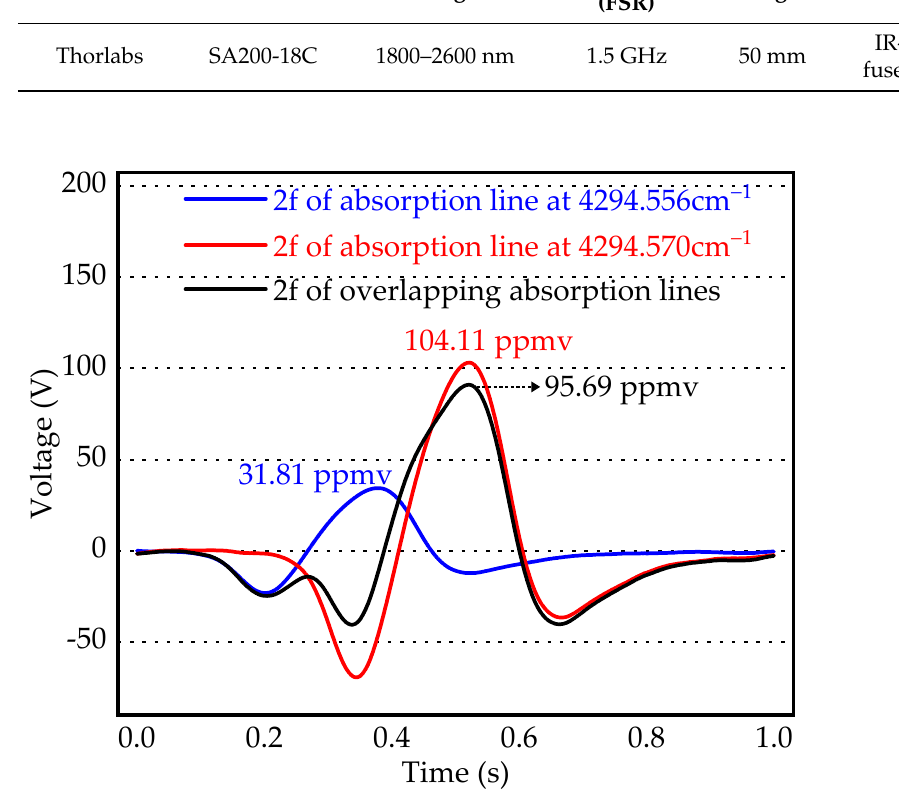
Figure 6. Separation effect of CH 4 overlapping absorption lines based on 2f-SR.